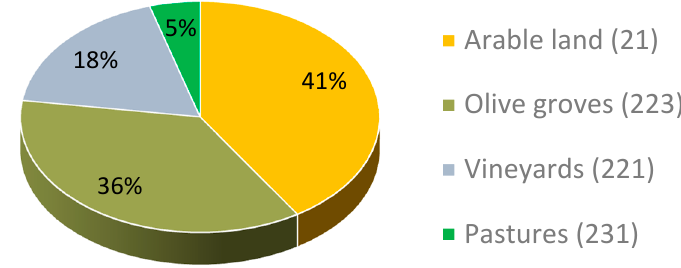
Figure 6. Share of the main agricultural land uses in Greece found to contain ephemeral gullies (CORINE coding in brackets).